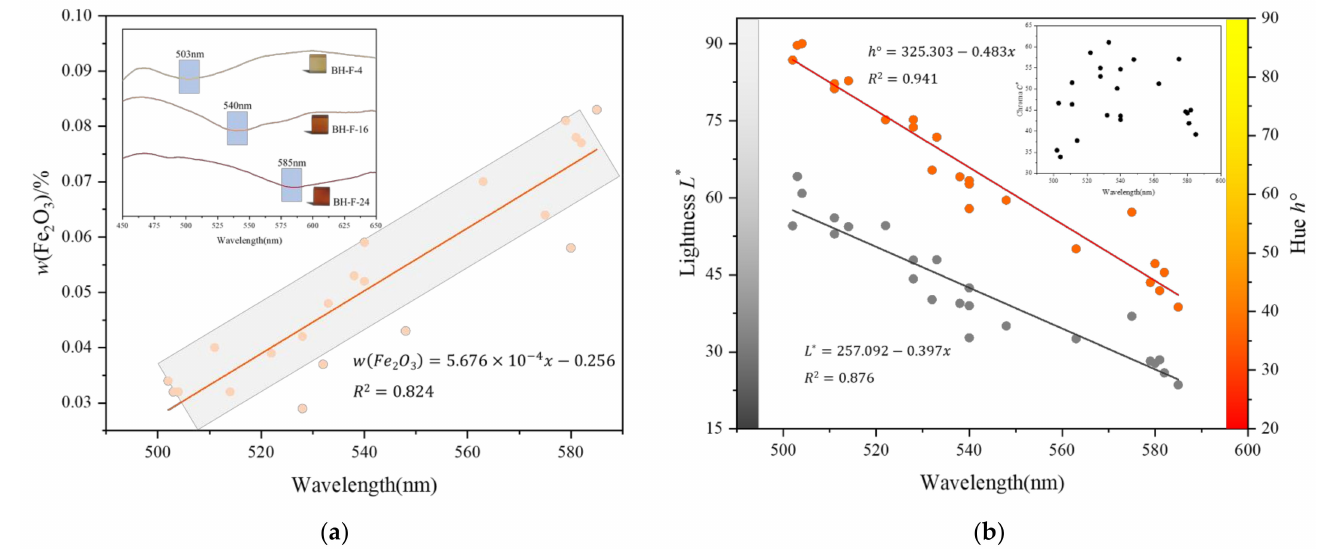
Figure 9. Relationships between the position of the primary trough within the range of 500–600 nm and the total Fe content and colour parameters. ( a ) With the position of the primary trough shifting to the long-wave direction, the total Fe content increases. ( b ) High negative correlations between the position of the primary trough and lightness and hue angle, but a weak correlation between the position and chroma shows in the upper right